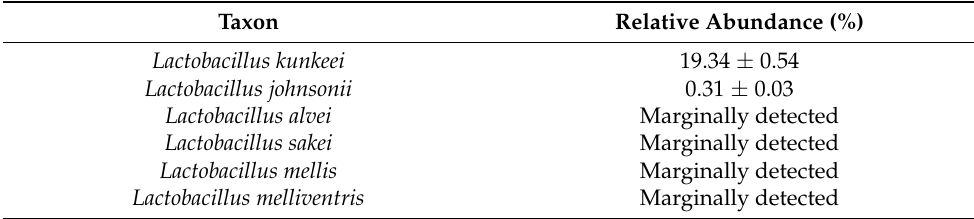
Table 1. Relative abundance of Lactobacillus species detected in fir honey.